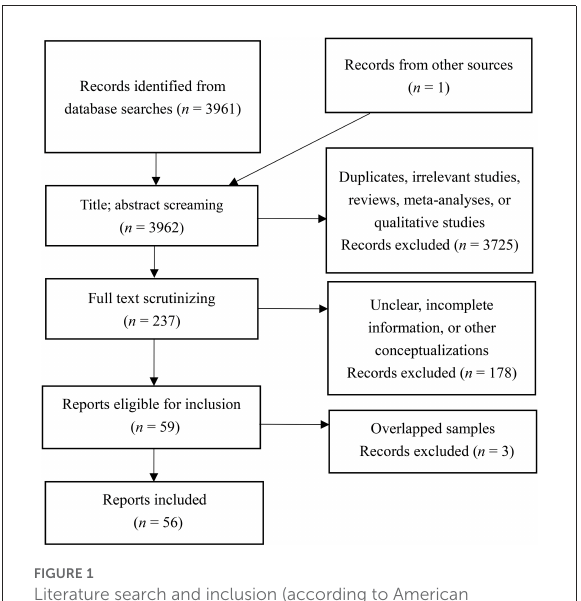
FIGURE1 Literature search and inclusion (according to American Psychological Association Meta-Analysis Reporting Standards,